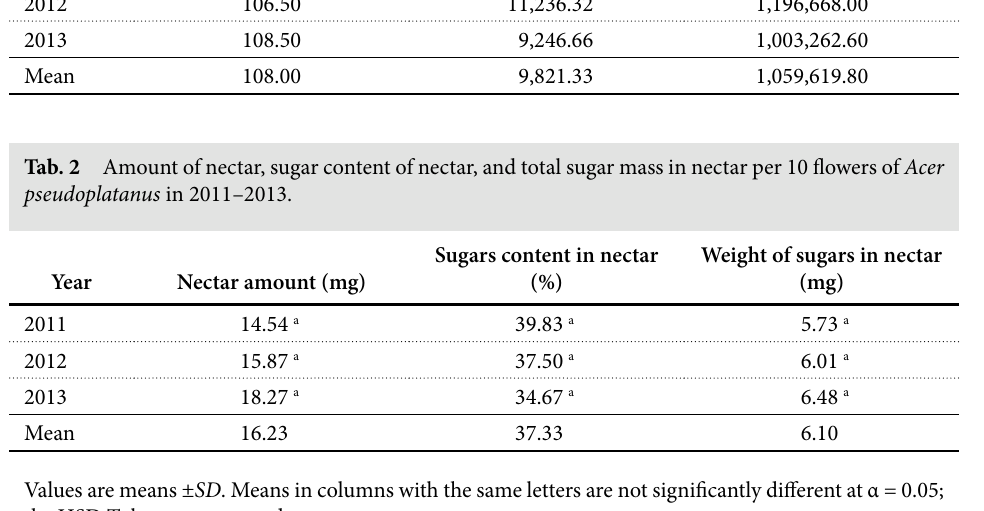
Values are means ± SD . Means in columns with the same letters are not significantly different at α = 0.05; the HSD Tukey test was used.